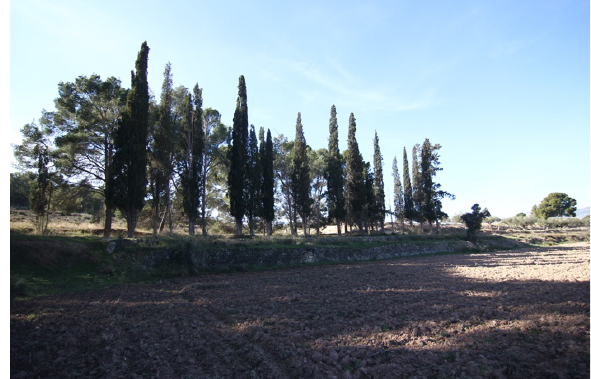
Figure 8. Cypresses path.